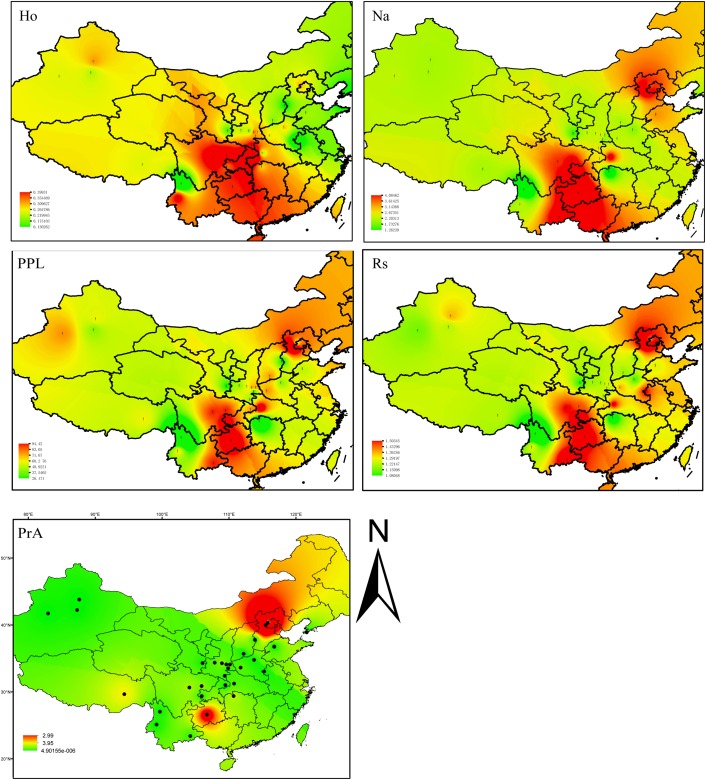
Inverse distance weighted (IDW) interpolation of the observed heterozygosity (HO), number of alleles (Na), percentage of polymorphic loci (PPL), allelic richness (Rs), and the number of private alleles calculated for 31commonwalnut populations (black dots) in the species, China range using 22 EST-SSR markers. The numbers of walnut populations are shown in Supplementary Table S1.